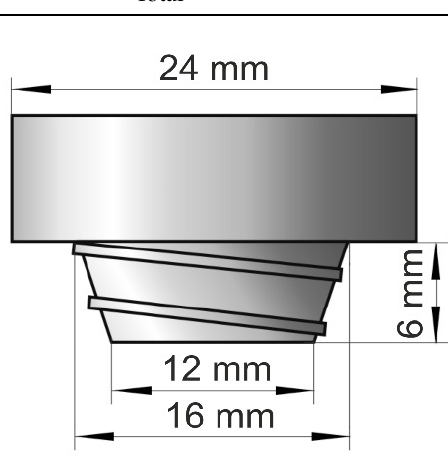
Figure 1. Diagram of Whorl pin used to modify surface of B89 alloy.